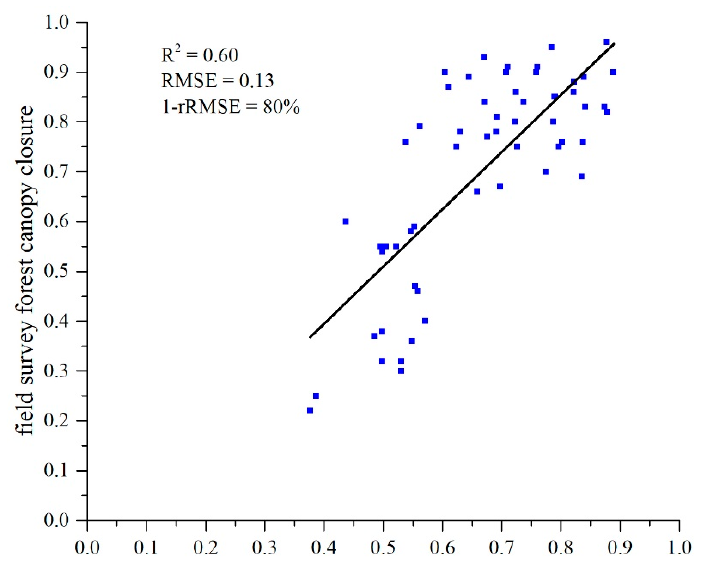
Figure 7. Accuracy Assessment for the canopy closure prediction using Landsat 8 satellite images.